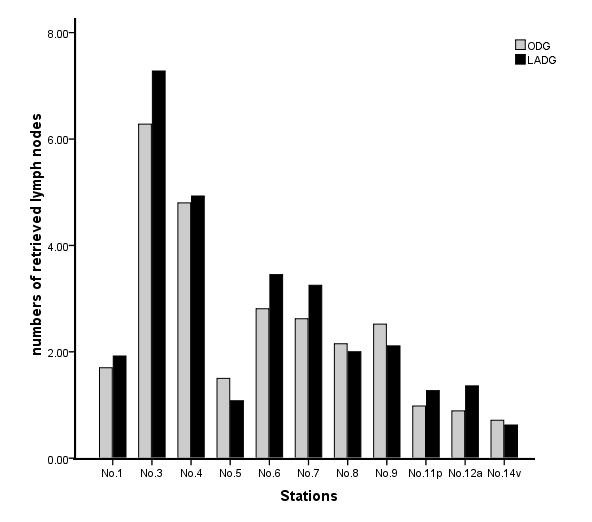
The retrieved lymph nodes from laparoscopy-assisted distal gastrectomy (black bar) and open distal gastrectomy (gray bar). There was no significant difference in the numbers of retrieved lymph nodes at each station.